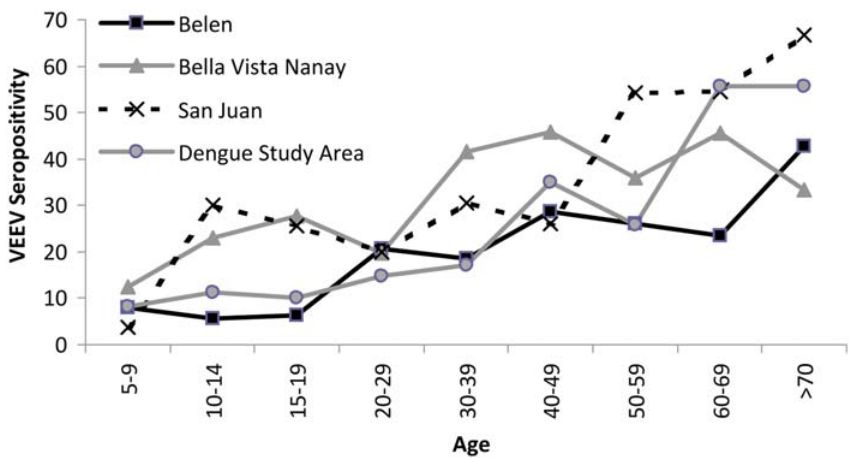
Figure 2. Age-dependent increase of VEEV-neutralizing antibodies.